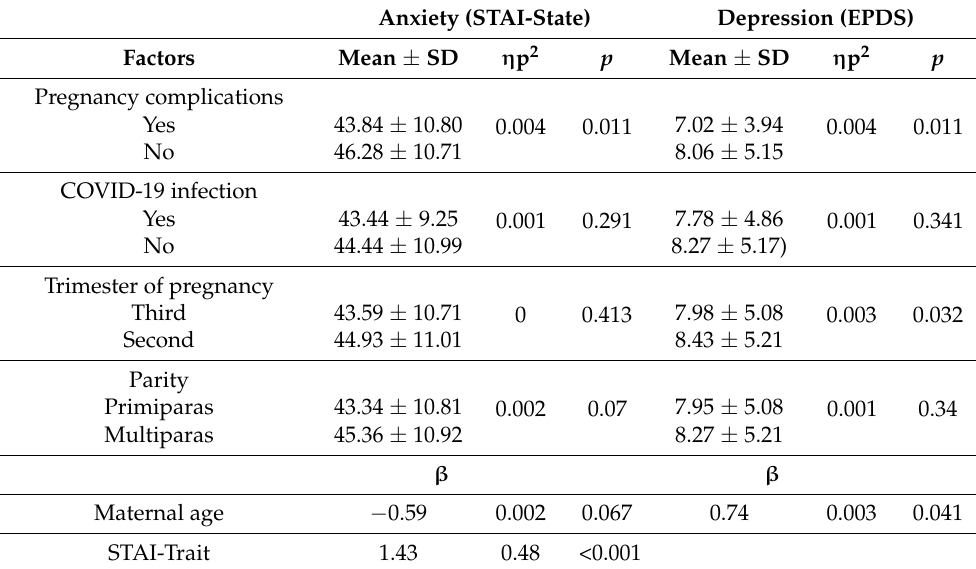
Table 2. The association between studied factors and the reported levels of STAI-State and EPDS. Statistically significant results are in bold. Anxiety (STAI-State) Depression (EPDS) Factors Mean ± SD η p 2 p Mean ± SD η p